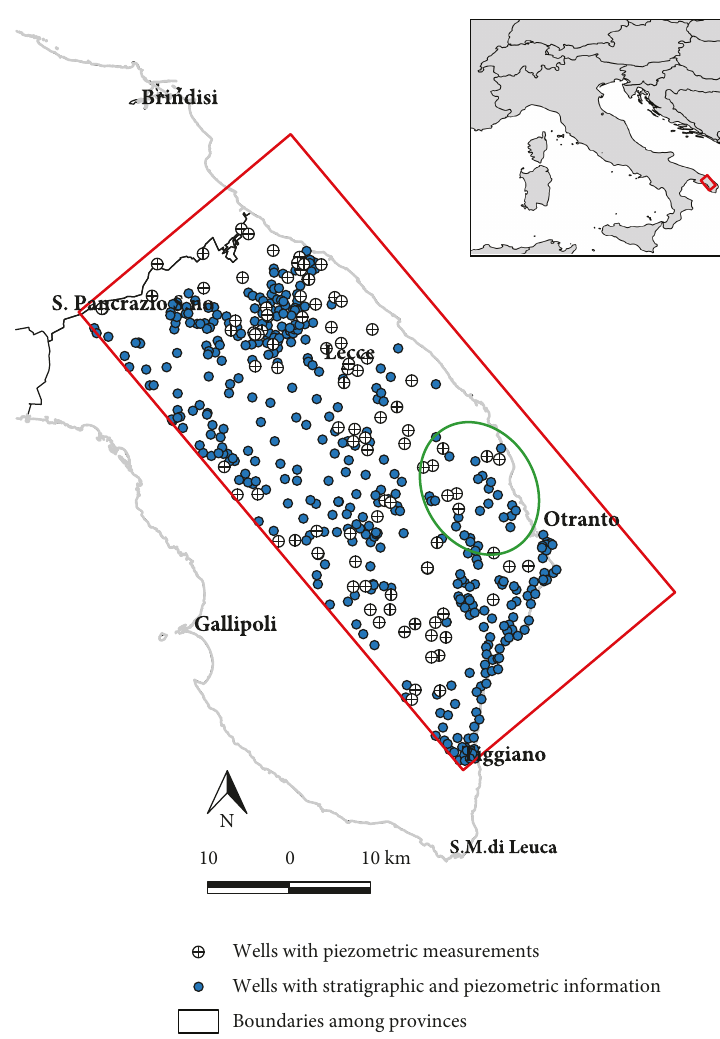
Figure 1: Location and extent of the study area and location of the wells where lithostratigraphic and piezometric information was available. The green circle indicates an area where the reconstruction of the stratigraphic setup needed speci fi c data